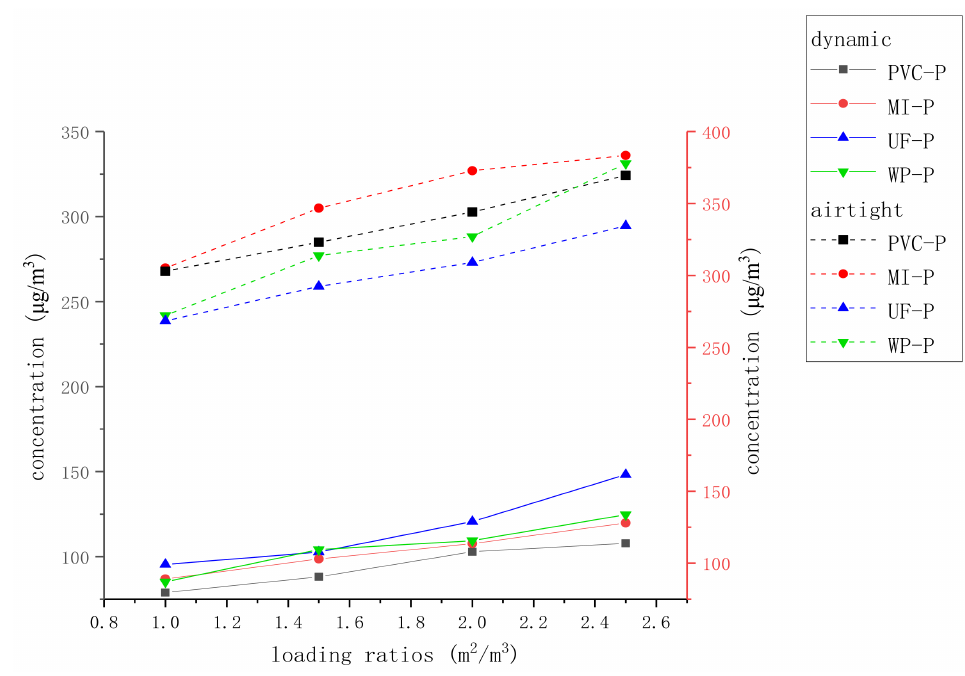
Figure 1. Comparison of 4 h dynamic and 4 h airtight